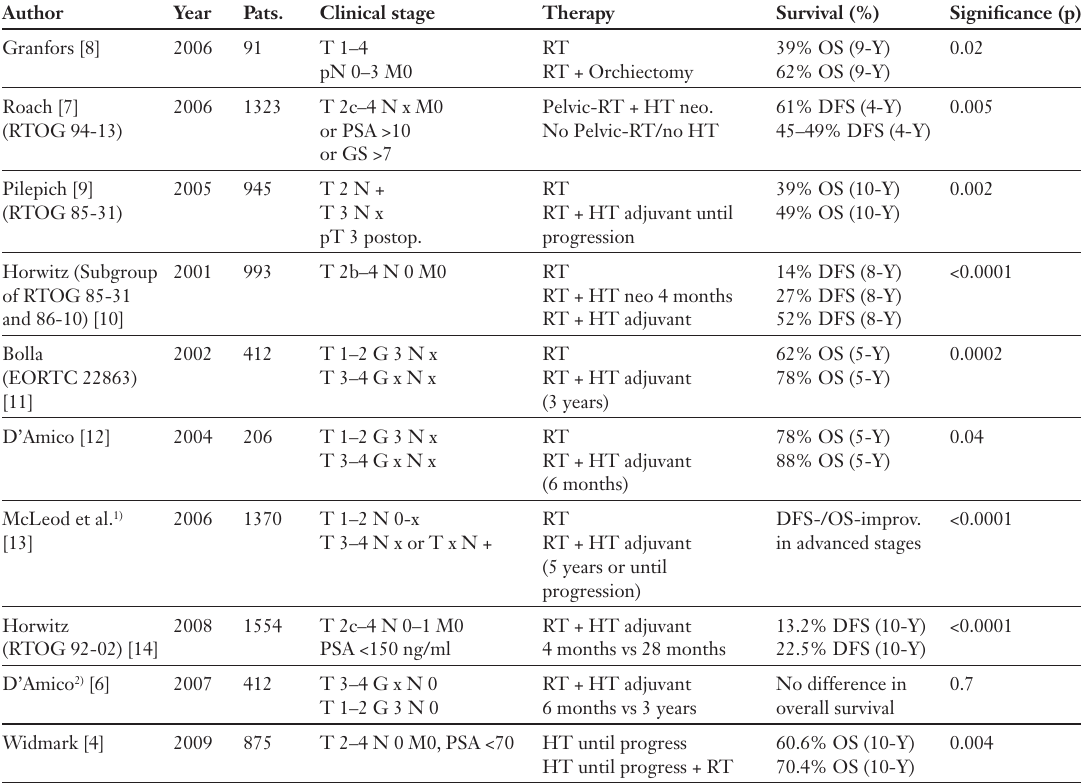
Results from ran- domised clinical trials with external radio- therapy plus/minus hormonal ablation: significant improve- ment in overall survival in locally advanced prostate cancer by long-term hormonal